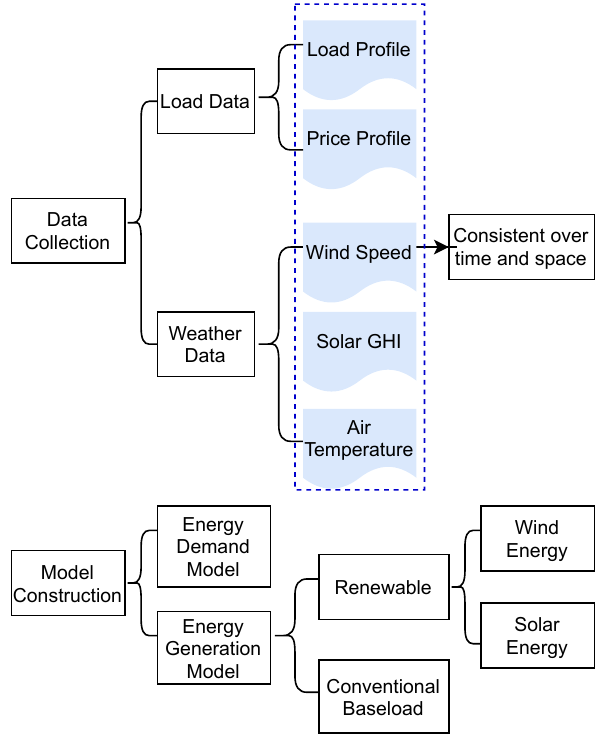
Figure 2. Step 1 is data collection and model